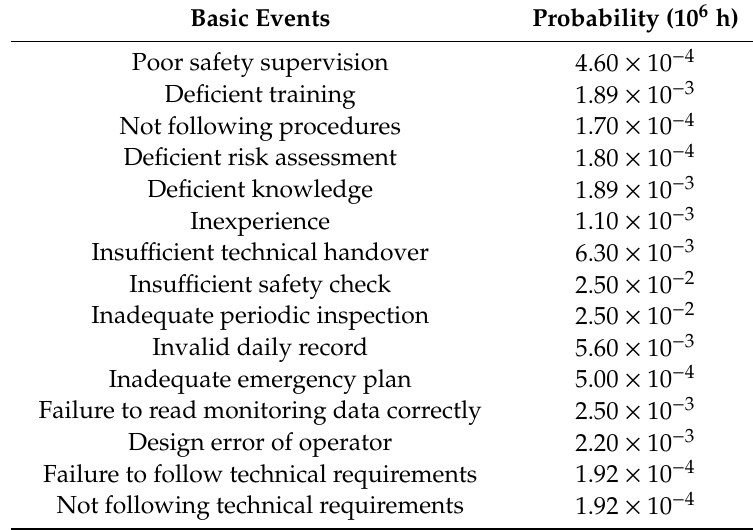
Table 1. Probability of relevant HOE basic events obtained from the literature